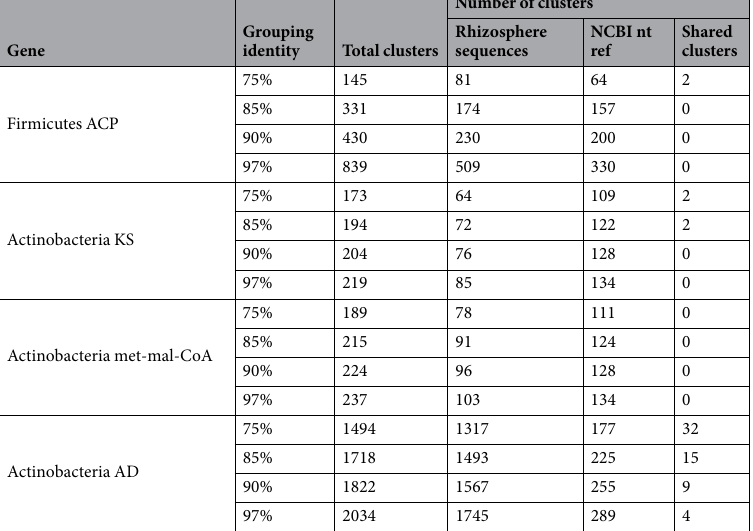
sampled from distinct plant growth stages and sites split into distinct lineages. The number of clusters formed when 454-sequences and NCBI nt reference database sequences were grouped at 85% identity are provided in Table 1. We observed a tremendous variation among sequences obtained in this study and representative sequences from the reference dataset. Phylogenetic trees showed an even distribution of sequences, i.e. SM gene sequences obtained from each site had representatives in each clade, although sequences did not assem- ble into site- or plant development-specific groups suggesting that SM biosynthesis is not limited by geography. Generally, the majority of clades did not associate with the reference clades (Figs 1, 2 and S3). For instance, met-mal-CoA diverged into one distinct clade indicating these biosynthetic clusters may originate from distinct ancestors (Fig. 2). Further representative sequences from the distinct clade were subjected to BLASTX analysis to predict the taxonomic origins. A substantial number of the met-mal-CoA genes was assigned to Streptomyces (50%), followed by Micromonospora (21.4%), Saccharothrix (12%), Amycolatopsis (10%), Herbidospora (2.3%) and Kibdelosporangium (2.3%) with protein similarities ranging from 55% to 79%. These genera were also identified in our previous 16S rRNA gene based community study and relative abundances of 16S rRNA genes derived from Streptomyces (ranging from 0.3 to 1.3%), Amycolatopsis (0.1–0.2%) and Kibdelosporangium (0.2%) 12 (Fig. S4). Although only 1% of the KS sequences shared similarities with the reference dataset sequences (Table 1), the phylogenetic distribution of the sequences obtained here revealed that a slightly higher fraction of the KS sequences fell into reference KS clades comprising known biosynthetic genes including reveromycin, baflomy- cin, sangifehrin, hygrocin, avermectin, concanamycin and nemdectin (Fig. 2). KS and met-mal-CoA domains are non-homologous, yet we grouped them on a single phylogenetic tree as one of them may serve as outgroup. Altogether, we found that many NRPS/PKS domains were only distantly related to known reference database sequences. Although SM biosynthetic genes from Actinobacteria have been extensively studied, our results show that a substantial fraction is yet unexplored (Figs 1, 2 and S3). SM biosynthetic genes change with plant development and vary across sites. To compare SM-derived gene sequences between two distinct plant growth stages (emergence and senescence) across three sampling sites and to see, whether site and/or growth stage significantly affected SM gene composition, we applied two strategies. First, Non-Metric Multidimensional Scaling (NMDS) ordination and second, multi- variate Generalized Linear Model (GLM) analysis were used. Shepard plot correlating the ordination distances based on Bray-Curtis dissimilarity between samples was applied to validate NMDS ordination analysis. In the NMDS plot, SM biosynthetic pathways, in particular AD and met-mal-CoA genes clearly separated between sampling sites (Fig. S5A,B), while no stable separation was obtained for ACP and KS genes from the iterative calculation of NMDS. This is further supported by a good linear fit between the observed dissimilarities and ordination distances visualized by a Shepard plot (Fig. S6). Multivariate GLM analysis for each SM derived OTU table further determined a significant effect of both plant growth stage and sampling site on ACP and AD gene sequence composition, however, KS and met-mal-CoA derived gene sequences differed only between sites (Table S2). Multivariate GLM analysis of 16S rRNA gene data (previously obtained 12 ) confirm previous findings based on principal component analysis 12 , which revealed that the rhizosphere microbiome assemblages are dis- tinct at emergence and senescence within a sampling site, but less pronounced across sampling sites. Generally, SM-encoding genes are more determined by site than growth stage, whereas (taxonomic) community composi- tion is mostly affected by the vegetation stage (Table S2). Nevertheless, also the vegetation stage is a major driver of subsets of SM-encoding genes, particularly AD domains (Table S2, Figs S5A and S6).